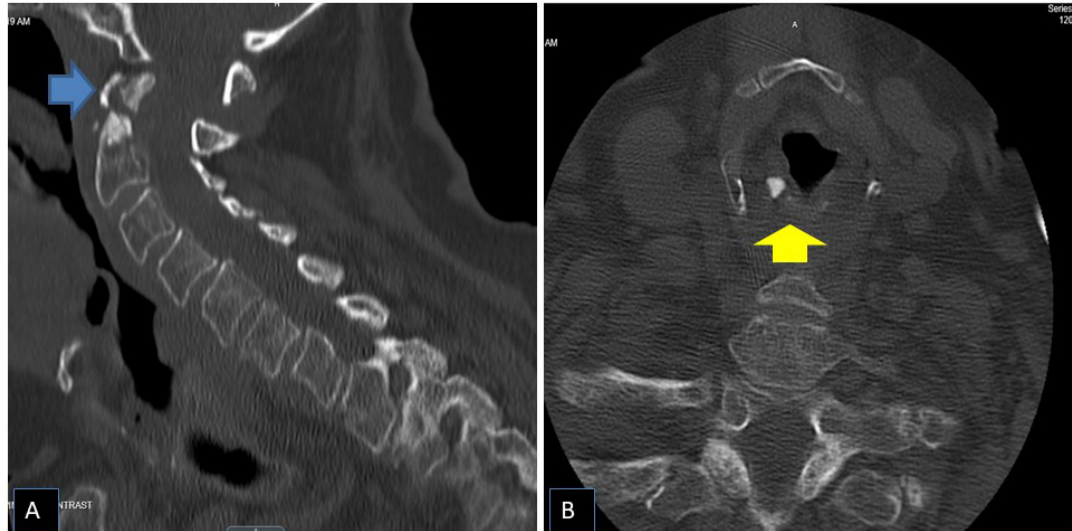
Figure 1. CT scan of the cervical neck showing Type II odontoid fracture (blue arrow) and sclerosis of the arytenoid cartilage (yellow